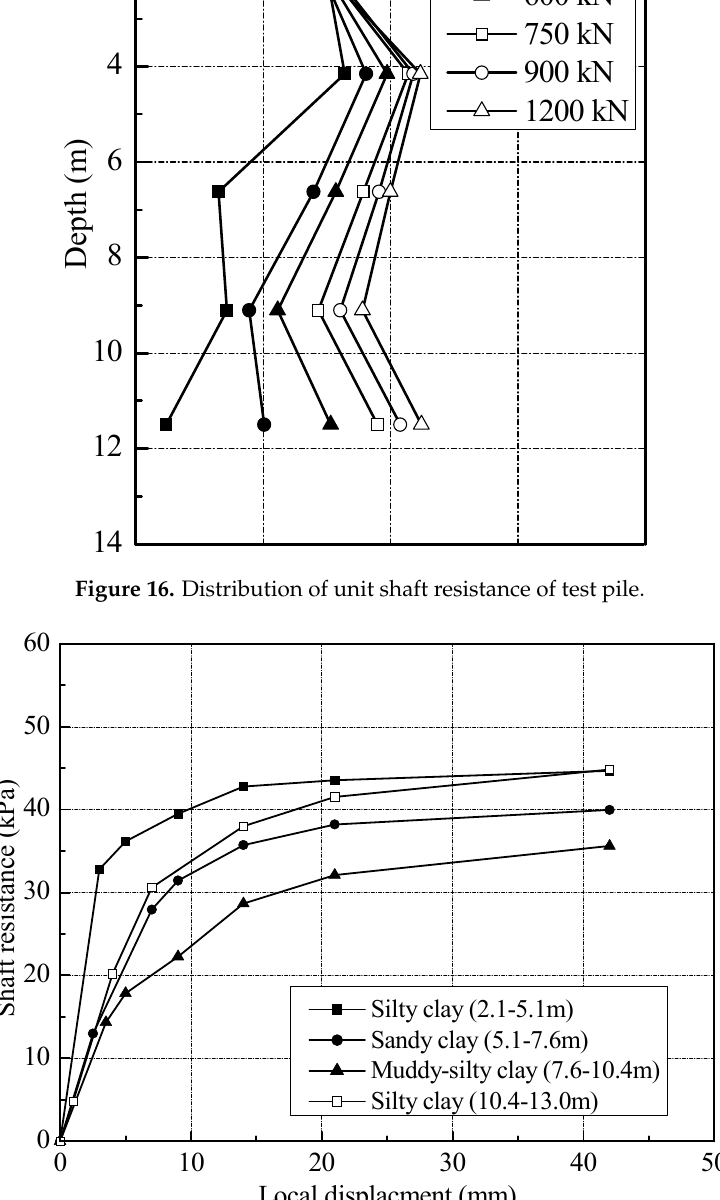
Figure 17. Local shaft resistance versus local displacement of test pile.